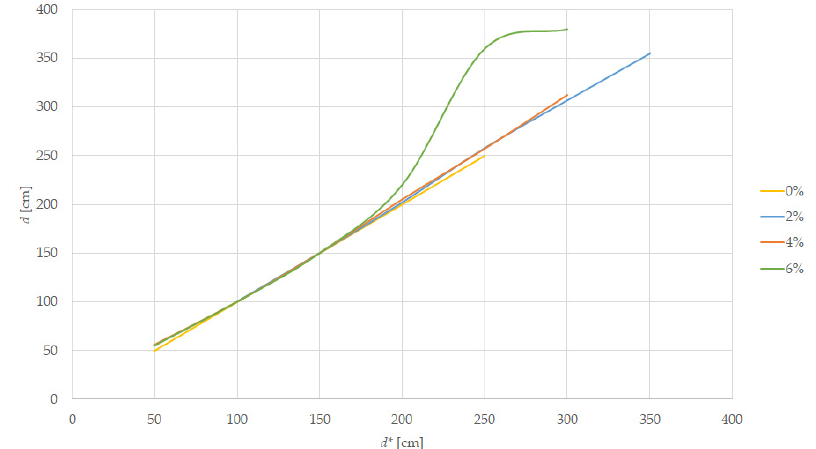
Figure 12. Distance measurement on downhill slope. The errors appear at 200 cm for the 2% slope, at 300 cm for the 4% slope, and 150 cm for the 6% slope; the sensed distance being the one to the wall, the target is no longer in the FoV of the sensor. The sensibility of the sensor is decreased because the sensor is